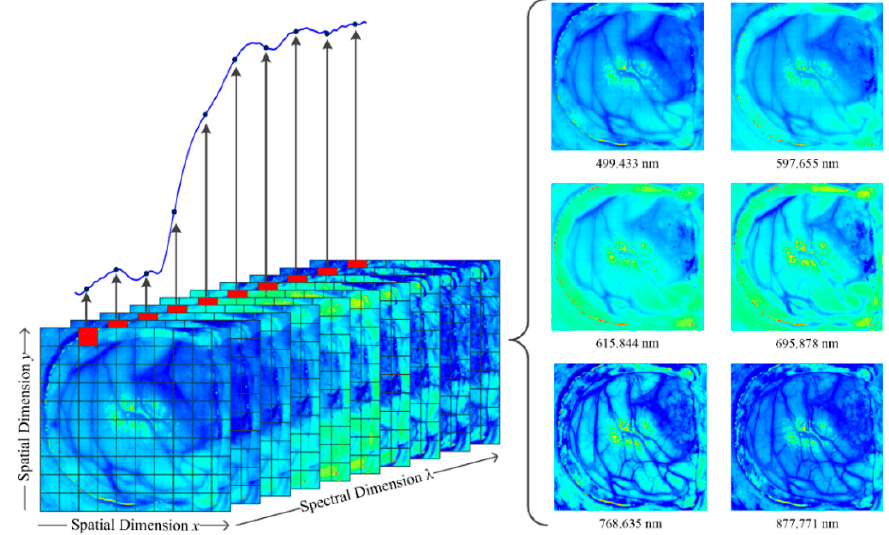
Figure 1. Example of an HS cube from in-vivo human brain surface and spectrum from the pixel in red ( left ). Several images at different wavelengths obtained from the HS datacube ( right ).